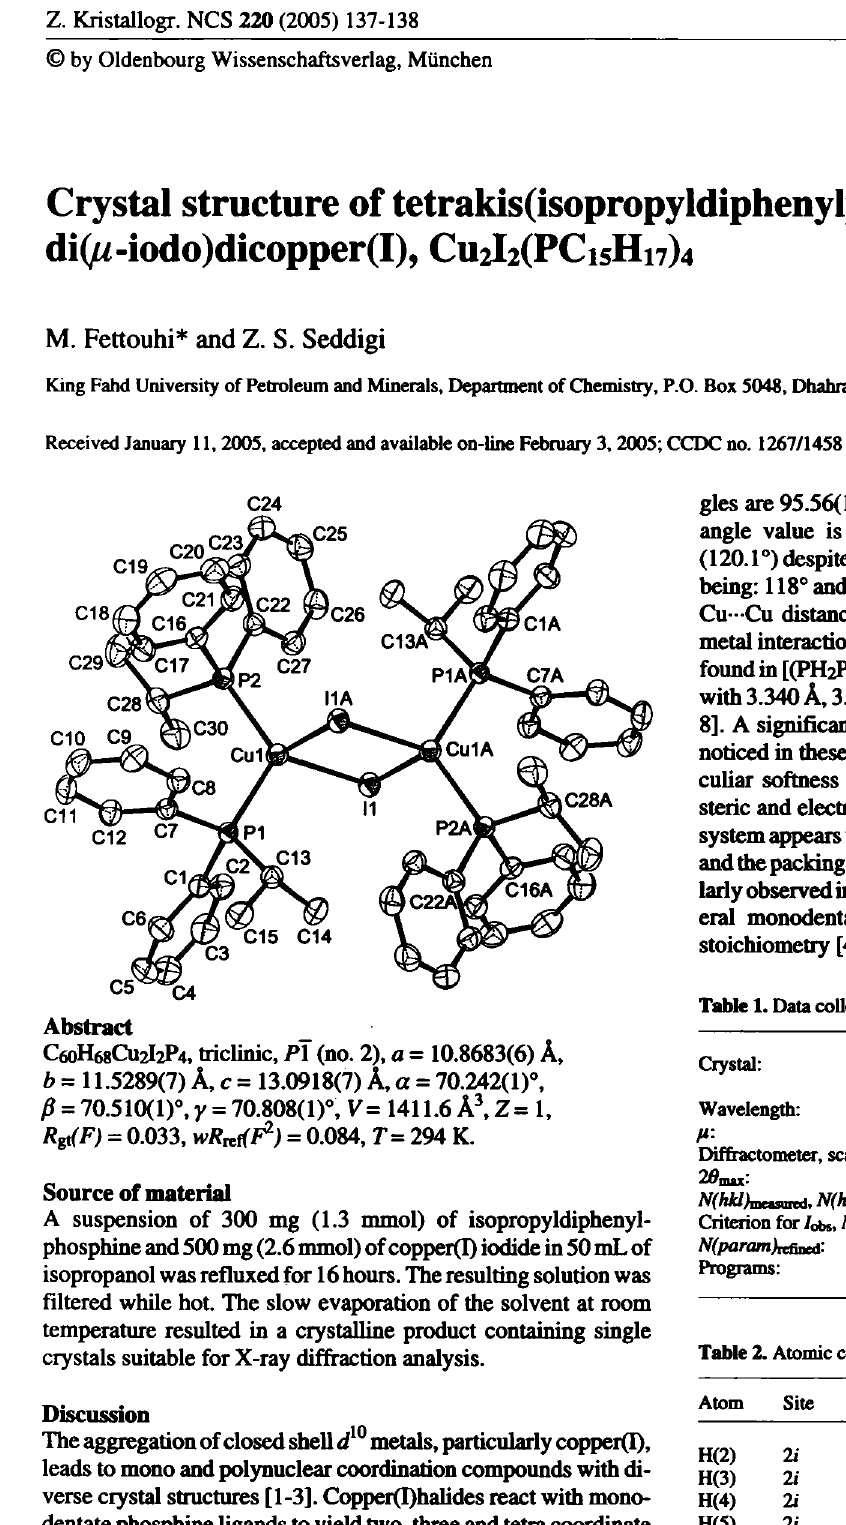
Table 2. Atomic coordinates and displacement parameters (in Ä 2